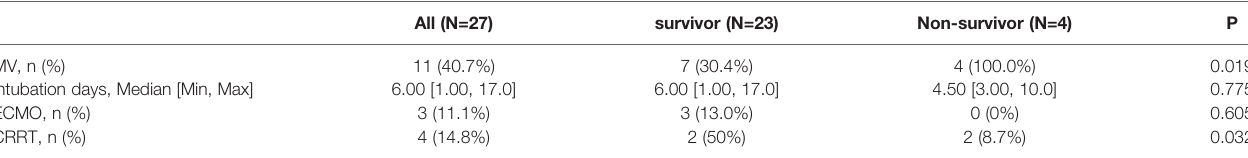
TABLE 3 | Treatment and outcomes.